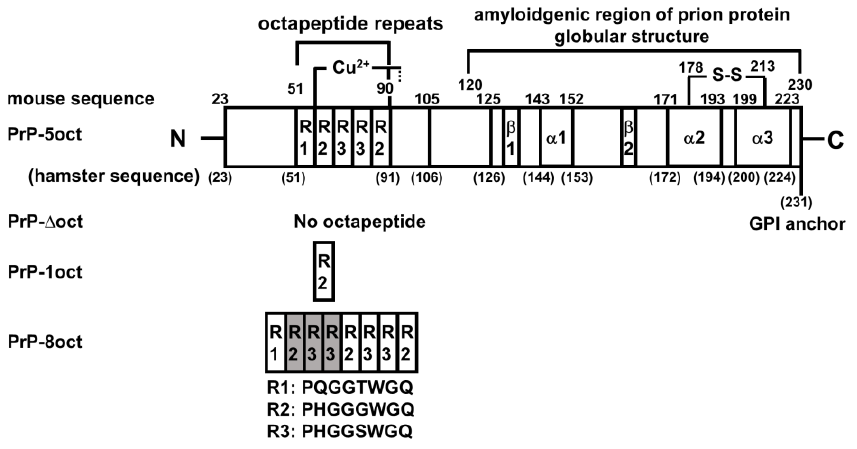
Figure 1. Representative scheme of prion sequence and prion proteins (PrP) variants with different number of octapeptide repeats. The sequences of the octapeptide repeats are represented by R1, R2 and R3. Three α -helices are labeled as α 1, α 2 and α 3. Two β -strands are labeled as β 1 and β 2.